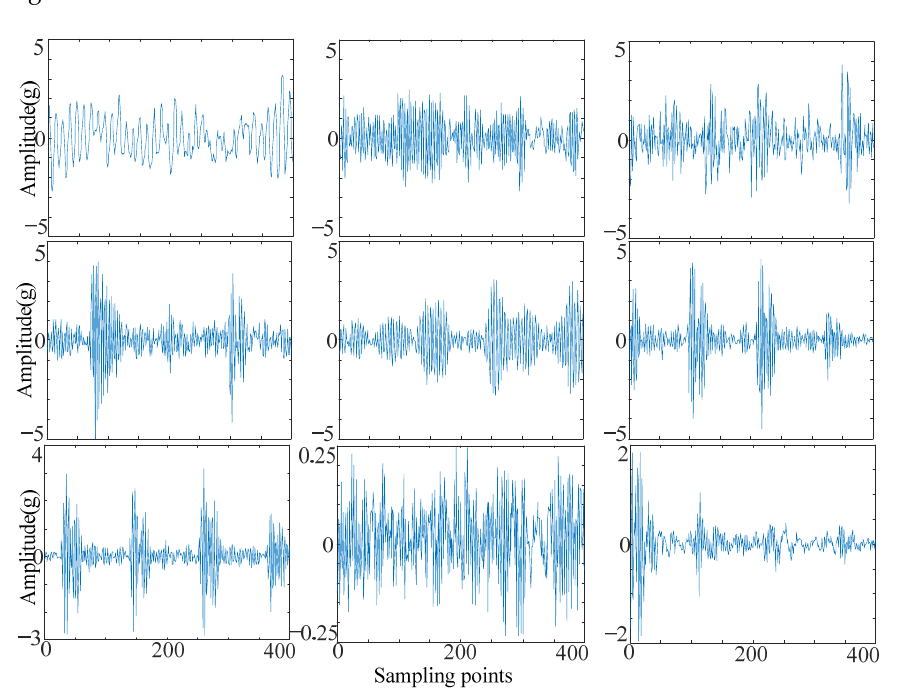
The acceleration signals for the nine types of faults on the drive end are shown in Figure 6.